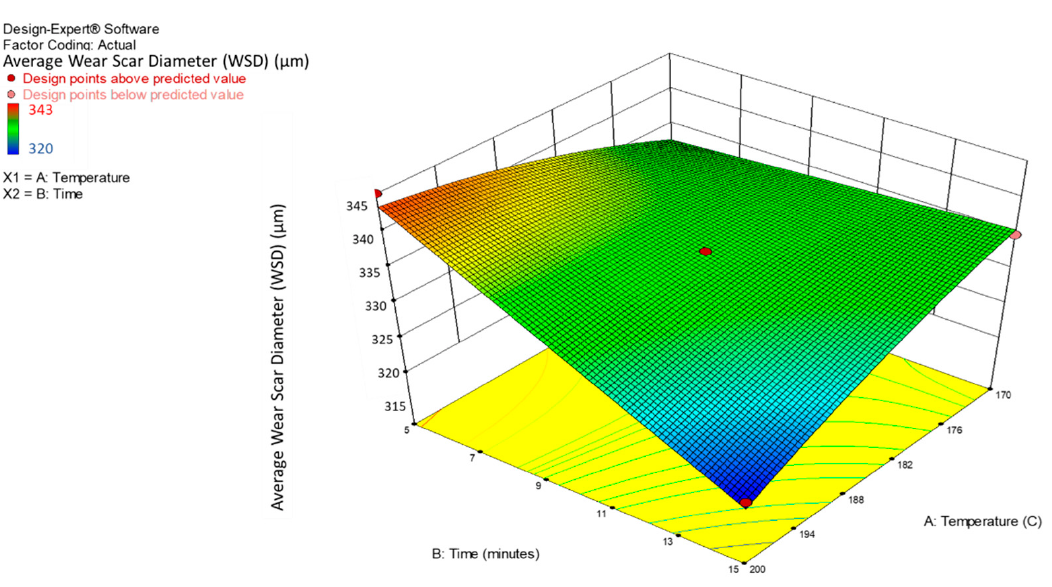
Figure 9. A 3D interaction plot of the average WSD for the MoS 2 nanolubricants.